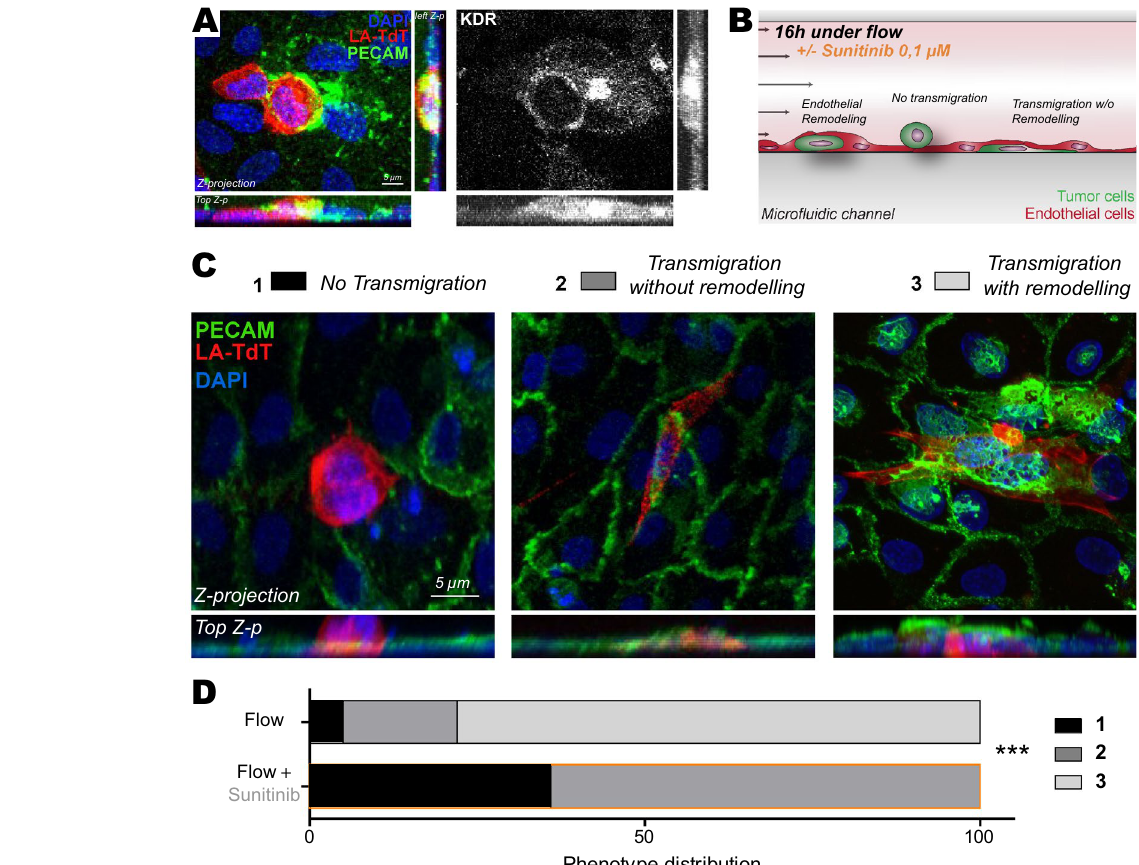
Figure 2. Inhibition of VEGFRs with sunitinib impairs endothelial remodeling in vitro. (A) Immuno-labelling pictures showing the presence of KDR (white) at the site of endothelial remodeling (Assessed with PECAM enrichment (green) around tumor cell (red)). Z-projections and two z-projection from side and top view are shown. ( B) Experimental setup: microfluidic channel for endothelial remodeling assay . (C) Representative images of all steps: 1-No transmigration, 2-Transmigration without remodeling evidence, 3-Transmigration with remodeling. Quantification of the normalized number of transmigrating cells and remodeling activity. ( D) Phenotypic distribution of CTCs attached to endothelial layers exposed to flow and treated with vehicle or sunitinib. N: flow/vehicle = 88, flow/sunitinib = 150, Fischer